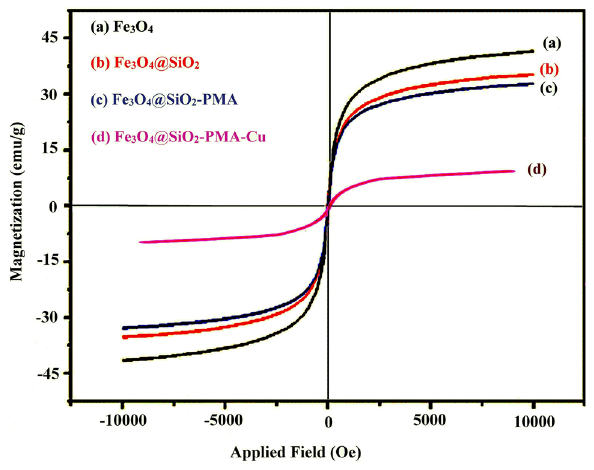
Figure 3. Magnetization curves of ( a ) Fe 3 O 4 , ( b ) Fe 3 O 4 @SiO 2 , ( c ) Fe 3 O 4 @SiO 2 -PMA and ( d ) Fe 3 O 4 @SiO 2 -